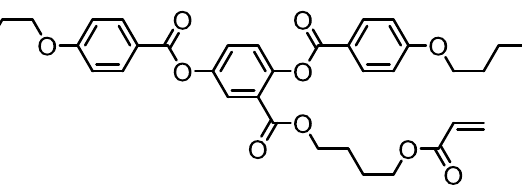
Figure 8. 4′-acryloyloxybutyl 2,5-(4′-butyloxybenzoyloxy)benzoate), a polymerisable azobenzene- based compound used in various studies of photoresponsive liquid crystal elastomers [93].